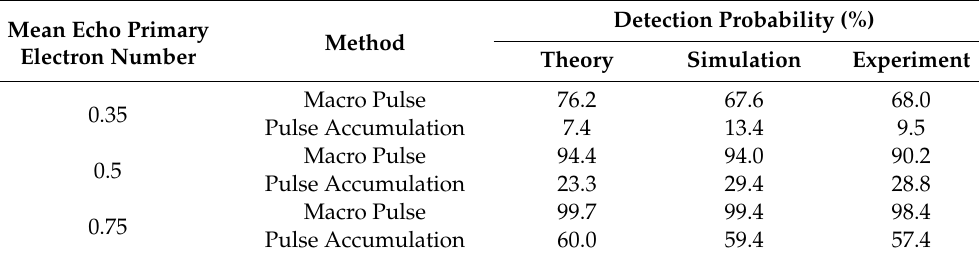
Table 5. Detection probability of the macro pulse method and pulse accumulation method.